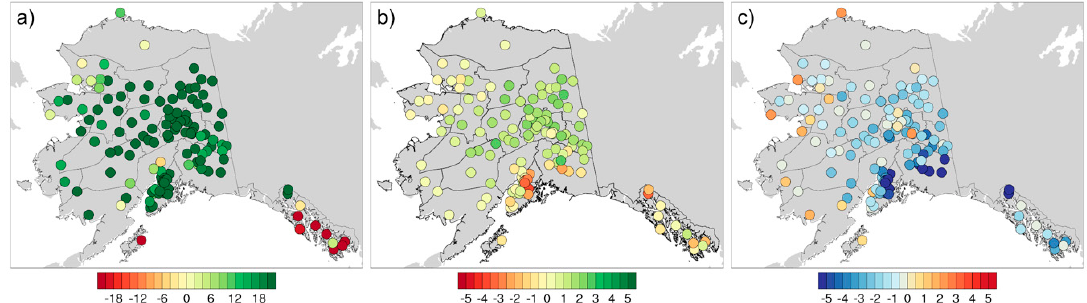
Figure 4. May–August 1996–2017 average daily differences (downscaled ERA-Interim reanalysis grid point minus station) for ( a ) precipitation, ( b ) 2-m dew point temperature, and ( c ) 2-m temperature. The start and end dates of the averages vary by the available record length at each station. Measurements were limited to stations with at least five years of data, and the differences were based on the same years for the reanalysis as the corresponding station. The units are millimeters in ( a ) and degrees Celsius in ( b , c ).